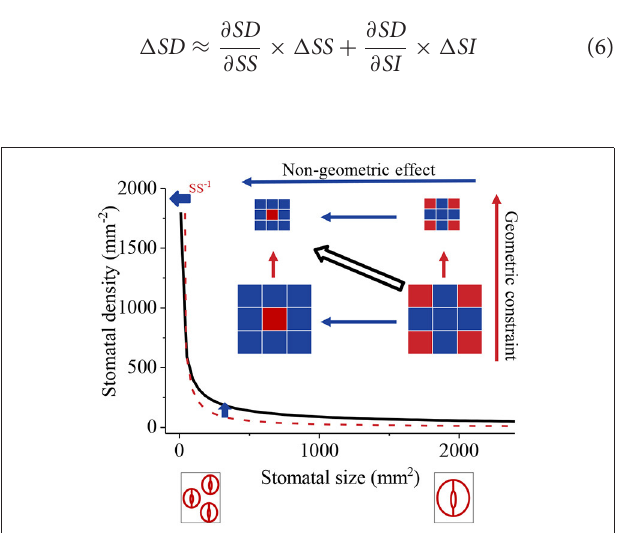
FIGURE 1 | Diagram of geometric constraint and non-geometric effect on the relationship between stomatal density (SD) and stomatal size (SS). Dark red squares and dark blue squares represent stomata and epidermal cells, respectively. The geometric constraint is the change in density caused by changes in square size; the non-geometric effect is the changes in density mainly caused by the ratio of the number of stomata to epidermal cells (stomatal index). When just the geometric constraint is considered, the observed SD-SS relationship (black line) was close to a power function with the exponent equal to − 1 (SD–SS − 1 , dark red dotted line), whereas the non-geometric effect diverged from the intrinsic line.